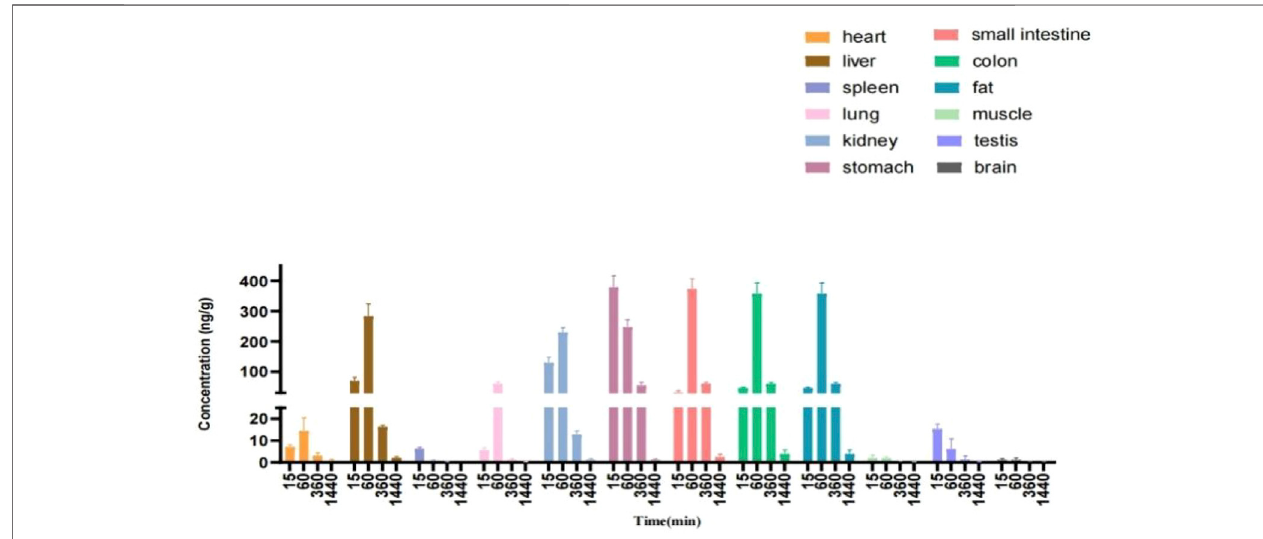
FIGURE 9 | Tissue distribution of YWS01125 (20 mg/kg) in C57/BL6J mice (mean ± SD, n = 6).